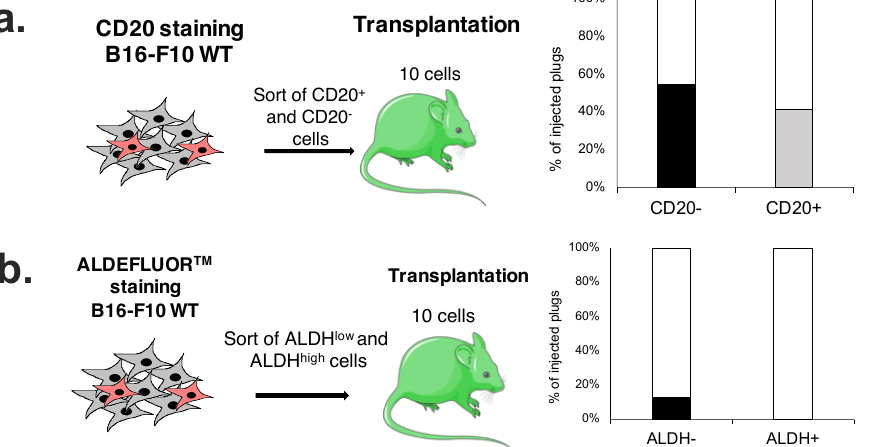
Figure 6. In vivo evaluation of tumorigenic potential of MIC subsets using syngeneic mice. Trans- plantation of 10 sorted cells for a chosen marker: ( a ) CD20 − /+ and ( b ) ALDH low/high (10 cells/plug, 2 plugs/mouse, n = 11–12